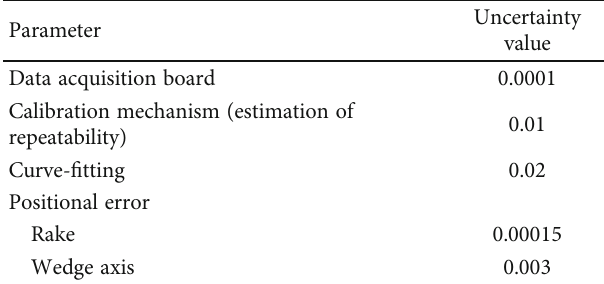
Table 2: The uncertainty for measured total